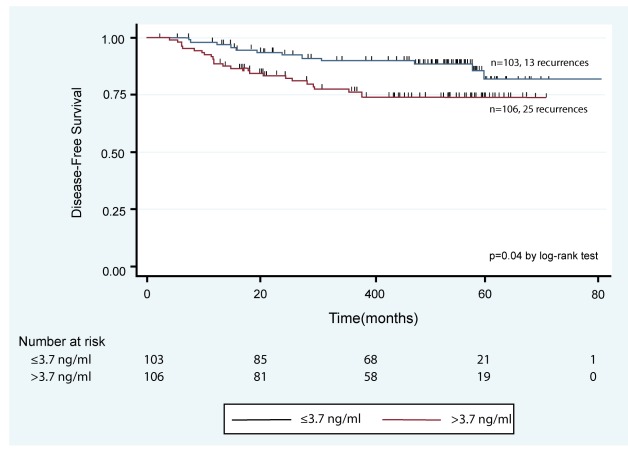
Kaplan-Meier plot for disease-free survival comparing patients with HU177 concentrations above and below the median value.
[178]